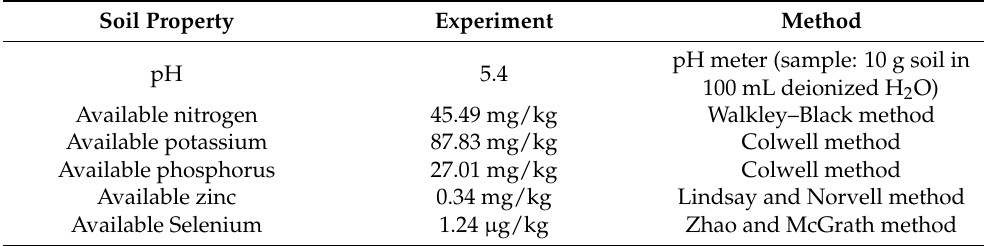
Table 6. Soil properties from the soil experiment.